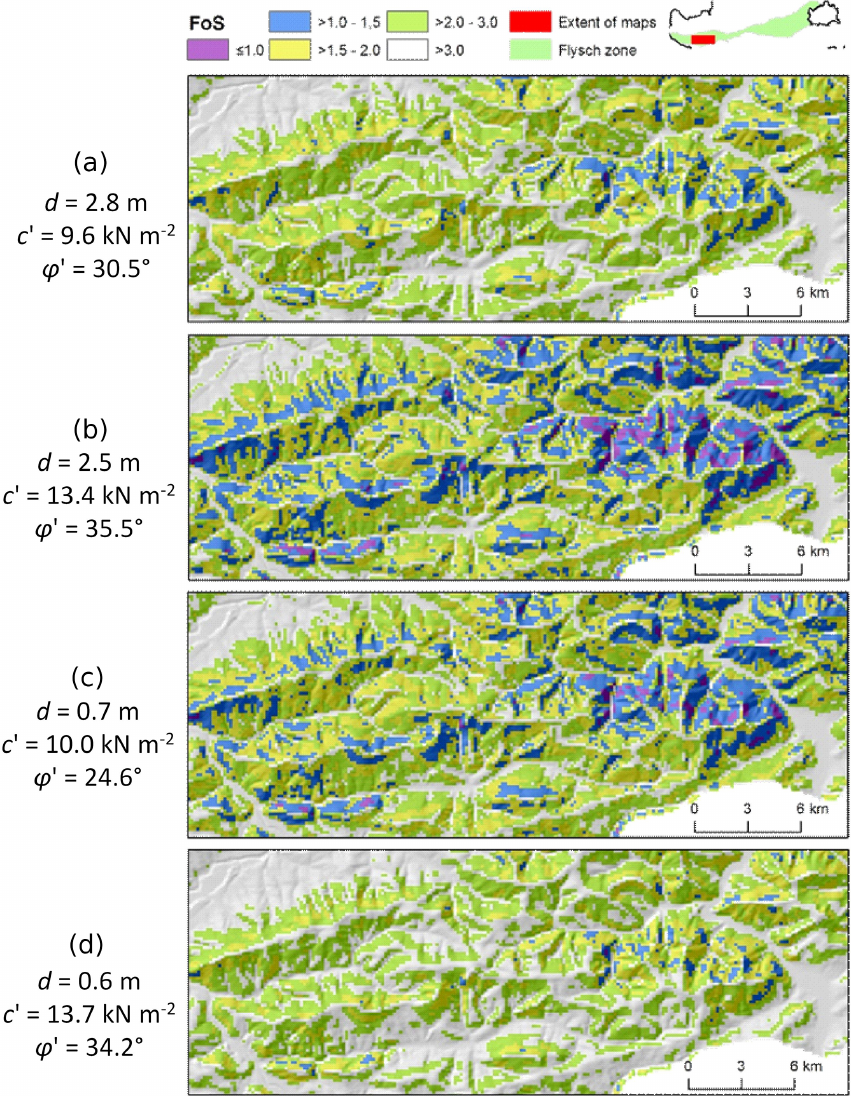
Figure 3. Selection of individual model iterations (postage stamp map). Each ensemble member was initialized with altered geotechnical parameters within a plausible range to account for variability and spatial uncertainty and for a specific rainfall event. FoS values < 1 indicate slope